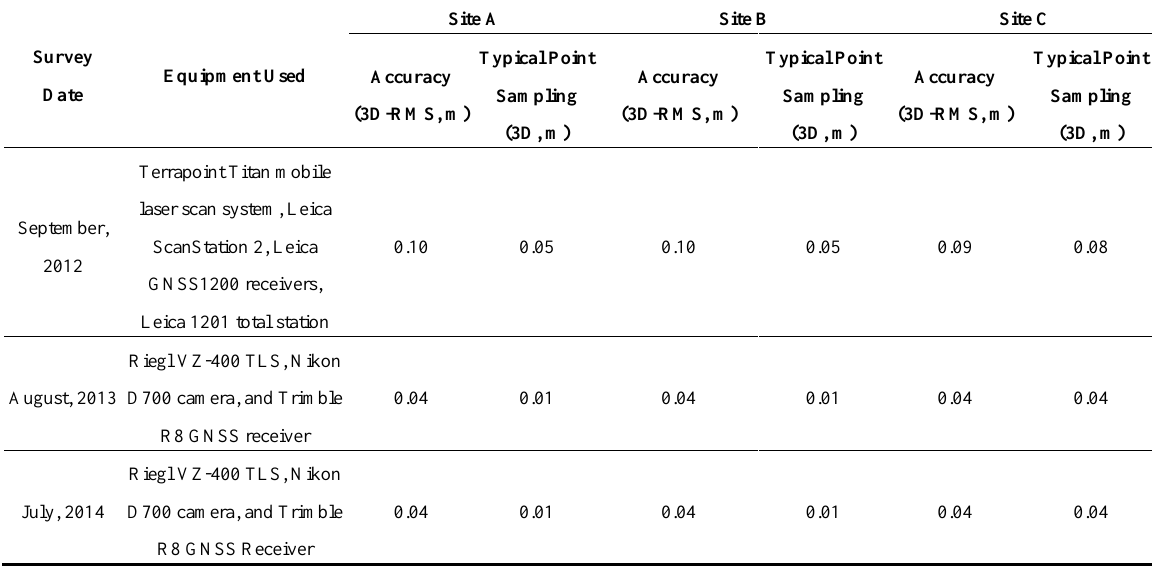
Table 1. Summary of survey data collected including typical accuracies and point sampling intervals on the cliff surface.